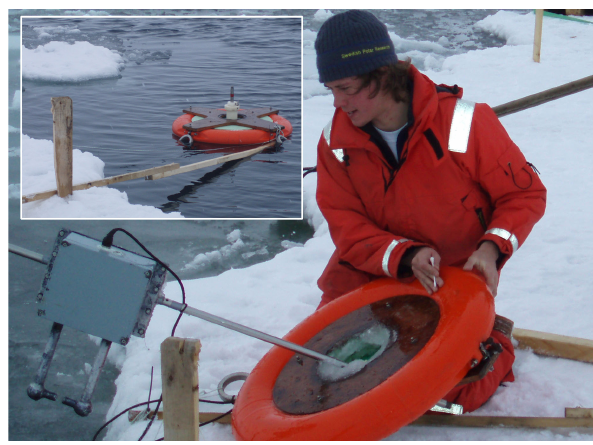
Fig. 4. The bubble camera being readied for deployment, and (inset) in position off the side of the ice floe.